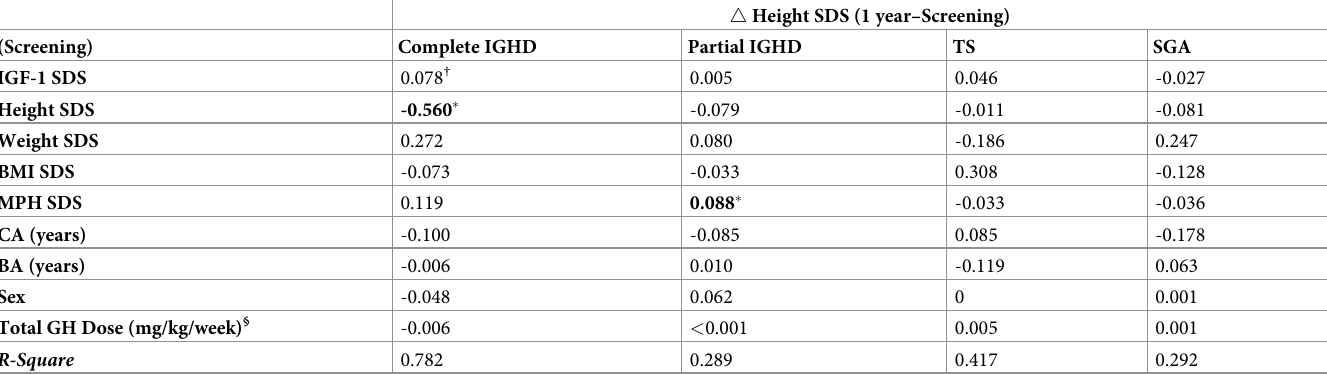
Table 3. Multiple regression analyses between the height response and screening measurements one year after treatment.